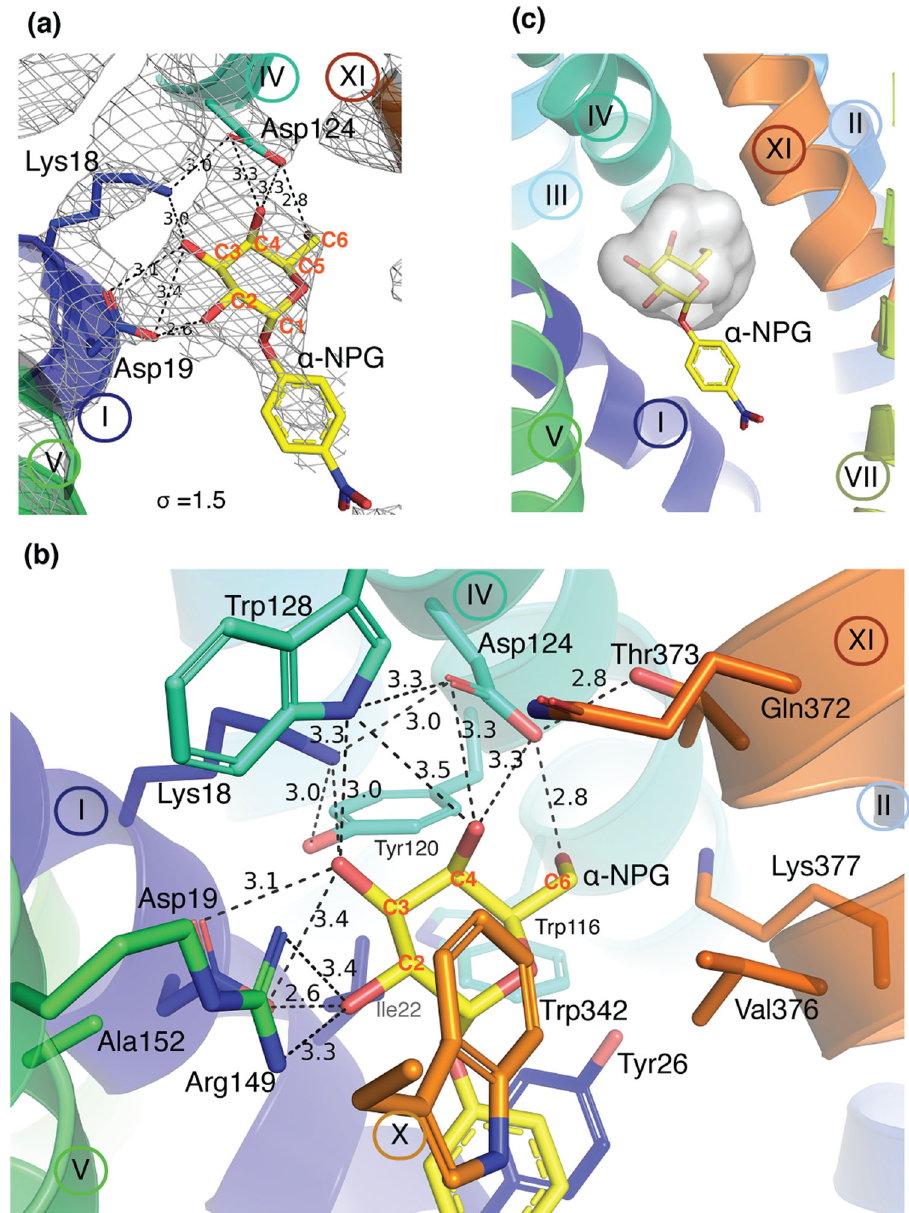
Fig. 3 α -NPG-binding site. The structure with bound α -NPG was re fi ned to a resolution of 3.05 Å [PDB ID, 7L17]. Helices are shown in a cartoon representation and labeled in Roman numerals; protein sidechains are shown in sticks, labeled in three letters, and color-matched with hosting helix. This style is used throughout this article. Carbon positions on the galactosyl ring are labeled in red. H-bond and salt-bridge interactions are judged by distance that is ≤ 3.5 Å and indicated by dashed lines with distance shown in Å. The α -NPG molecule is shown in stick and the carbons are colored in yellow with oxygen in red and nitrogen in blue. a 2Fo-Fc electron-density map. A molecule of α -NPG is fi tted to the electron density (contoured to 1.5 σ ). Residues Asp19 and Lys18 (helix I) and Asp19 (Helix IV) form multiple strong H-bonds with all four OH groups on the galactosyl ring of α -NPG. b Sugar-binding site. Helix I (residues Lys18 and Asp124), helix IV (residues Tyr120, Asp124, Trp128), helix V (Arg149), and helix XI (residues Thr373) are involved in a charge- assisted H-bond network with all four OH groups on the speci fi c galactosyl ring. Ile22 and Tyr26 (helix I), Trp342 (helix X), Val376 (helix XI) on helix IV are approximately 4 Å away and provide hydrophobic environment for galactosyl ring and/or phenyl ring. Few residues at longer distances are also shown up including Trp116 (helix IV) and Gln372 & Lys377 (helix XI). c Sugar speci fi city determinant pocket. The binding residues listed in panel b is shown in cavity presentation and colored in gray, where only hosts the galactosyl moiety of the α -NPG